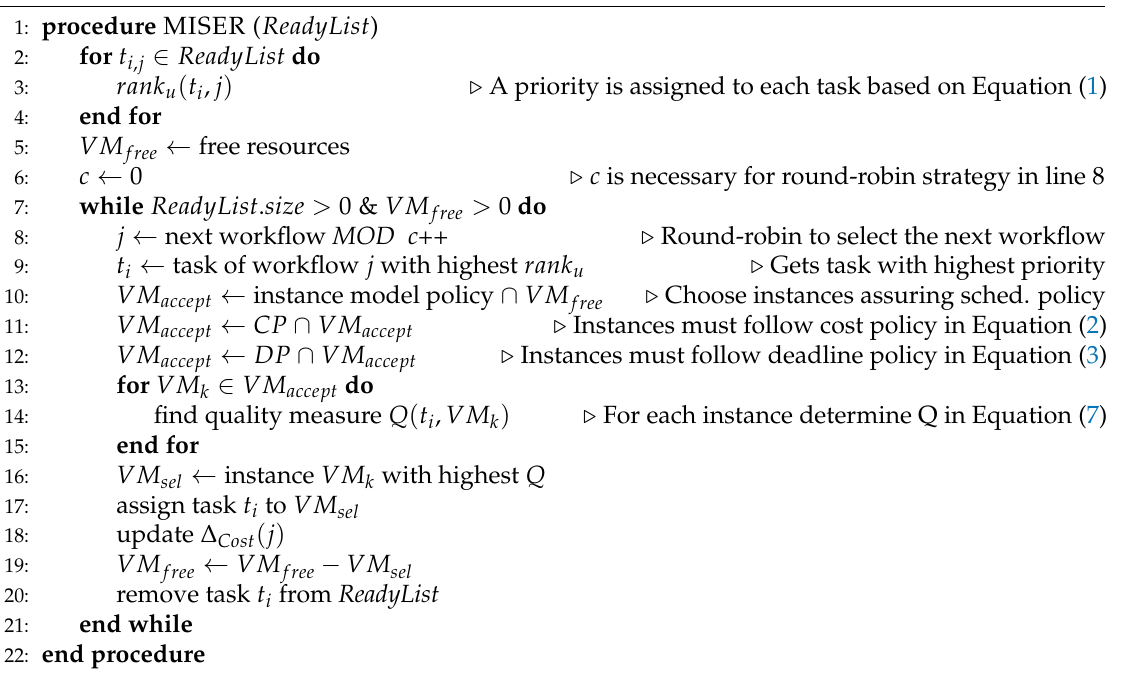
Algorithm 1 MISER scheduling